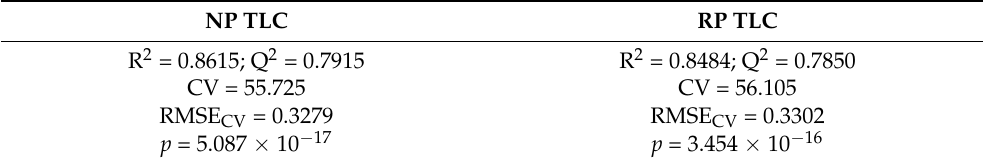
Figure 4. Scatter plot of predicted vs. observed B2 values in an RF model using NP TLC data. R2 = coefficient of determination; Q2 = coefficient of determination for the cross-validated models; RMSECV = root-mean-square error of cross-validation. Table 8. RF modelling results, models were created 20 times, and each time different decision trees were